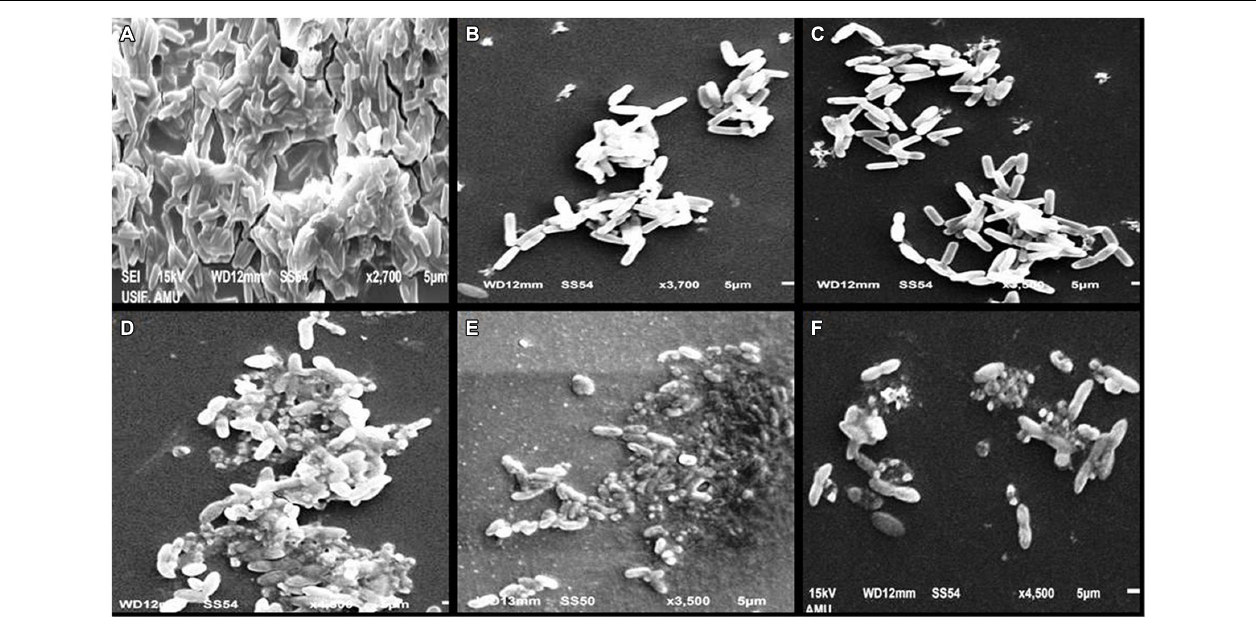
FIGURE 4 | Scanning electron microscopic (SEM) images for inhibition of biofilm of Pseudomonas aeruginosa PA01 at sub-MICs. (A) Control; (B) PMO (3% v/v); (C) Menthol (800 μ g mL − 1 ); (D) Aeromonas hydrophila WAF38 control ; (E) PMO (0.8% v/v ); (F) menthol (200 μ g mL − 1 ).